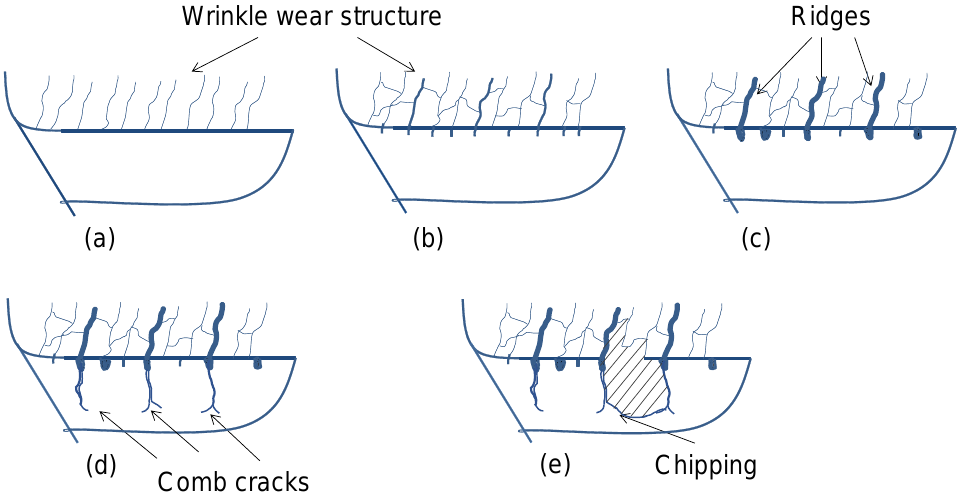
Figure 10. Main steps of wear evolution during milling of cast iron for both Ti(C,N)/ α -Al 2 O 3 system and Zr(C,N)/ α -Al 2 O 3 system.